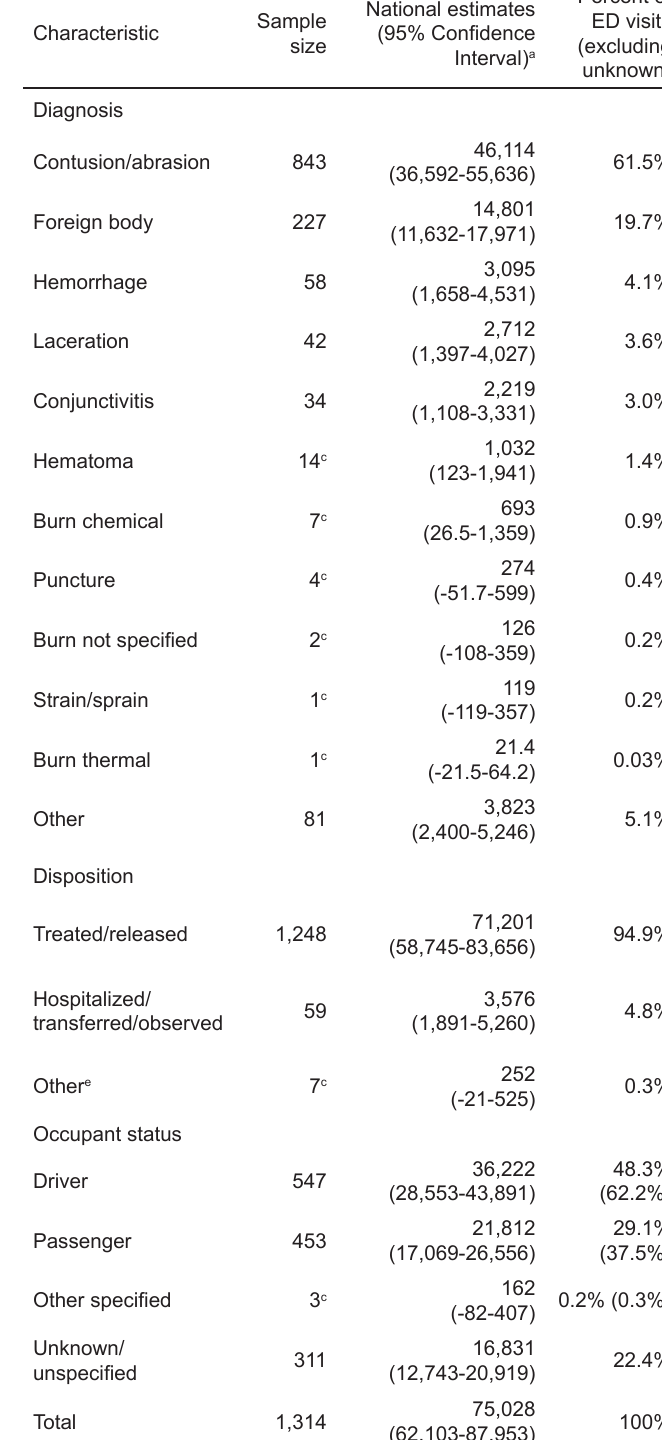
Table 5. Race and ethnicity breakdown of motor vehicle crash- associated eye injuries treated in U.S. emergency departments, 2001-2008.